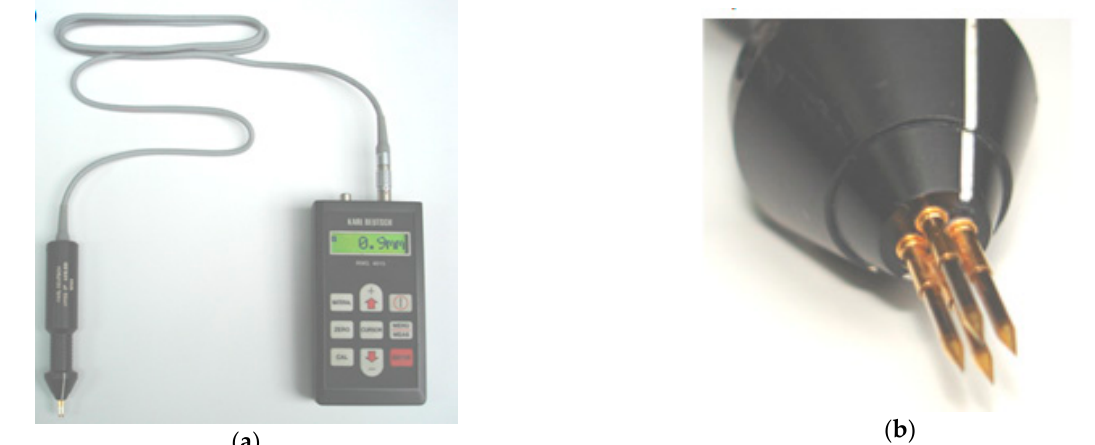
Figure 4. Instrument for crack depth measurement, type RMG 4015, made by Karl Deutsch: ( a ) general view and ( b ) head for cracks perpendicular to the surface.